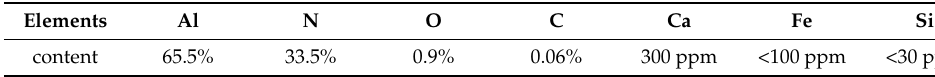
Table 1. The specific chemical composition of AlN